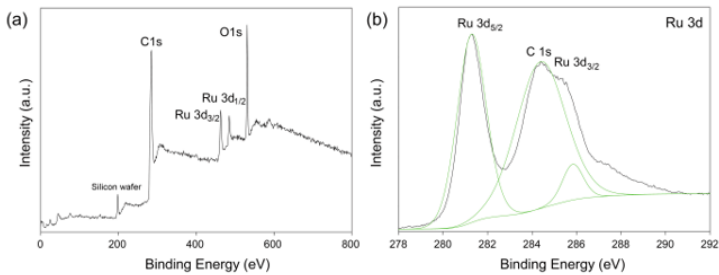
Figure 4. XPS spectra of RuO 2 /IL–graphene: ( a ) Survey scan and ( b ) core level of Ru 3d and C 1s. Table 1. Selective aerobic alcohol oxidation in the presence of various ruthenium catalysts. Entry Catalyst Conv. [b] (%) Select. (%) RuO 2 /IL-graphene [a] >99